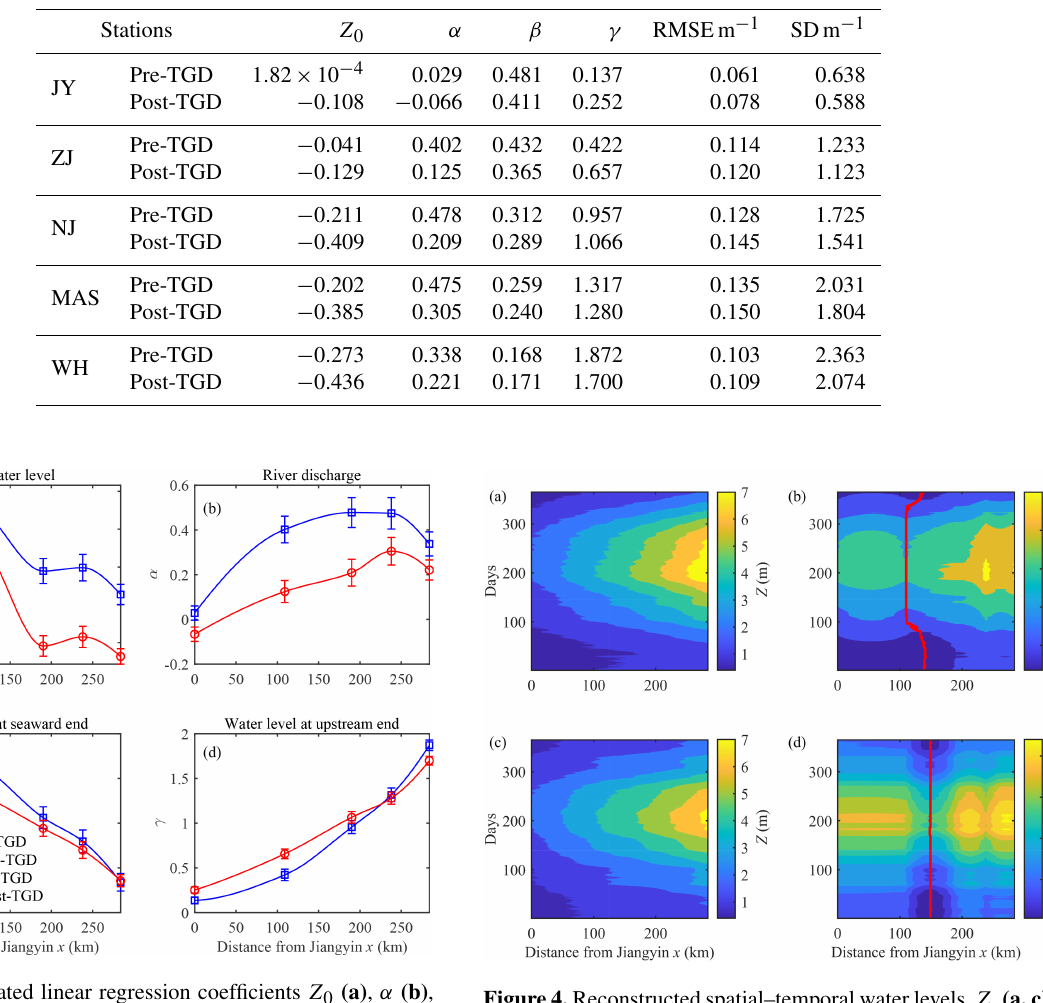
Figure 4. Reconstructed spatial–temporal water levels, Z , (a, c) and their slopes, S , (b, d) for the climatological year during both the pre-TGD (a, b) and post-TGD (c, d) periods. The red lines in pan- els (b) and (d) indicate the local minimum water level slopes in the central section of the YRE (between Jiangyin and